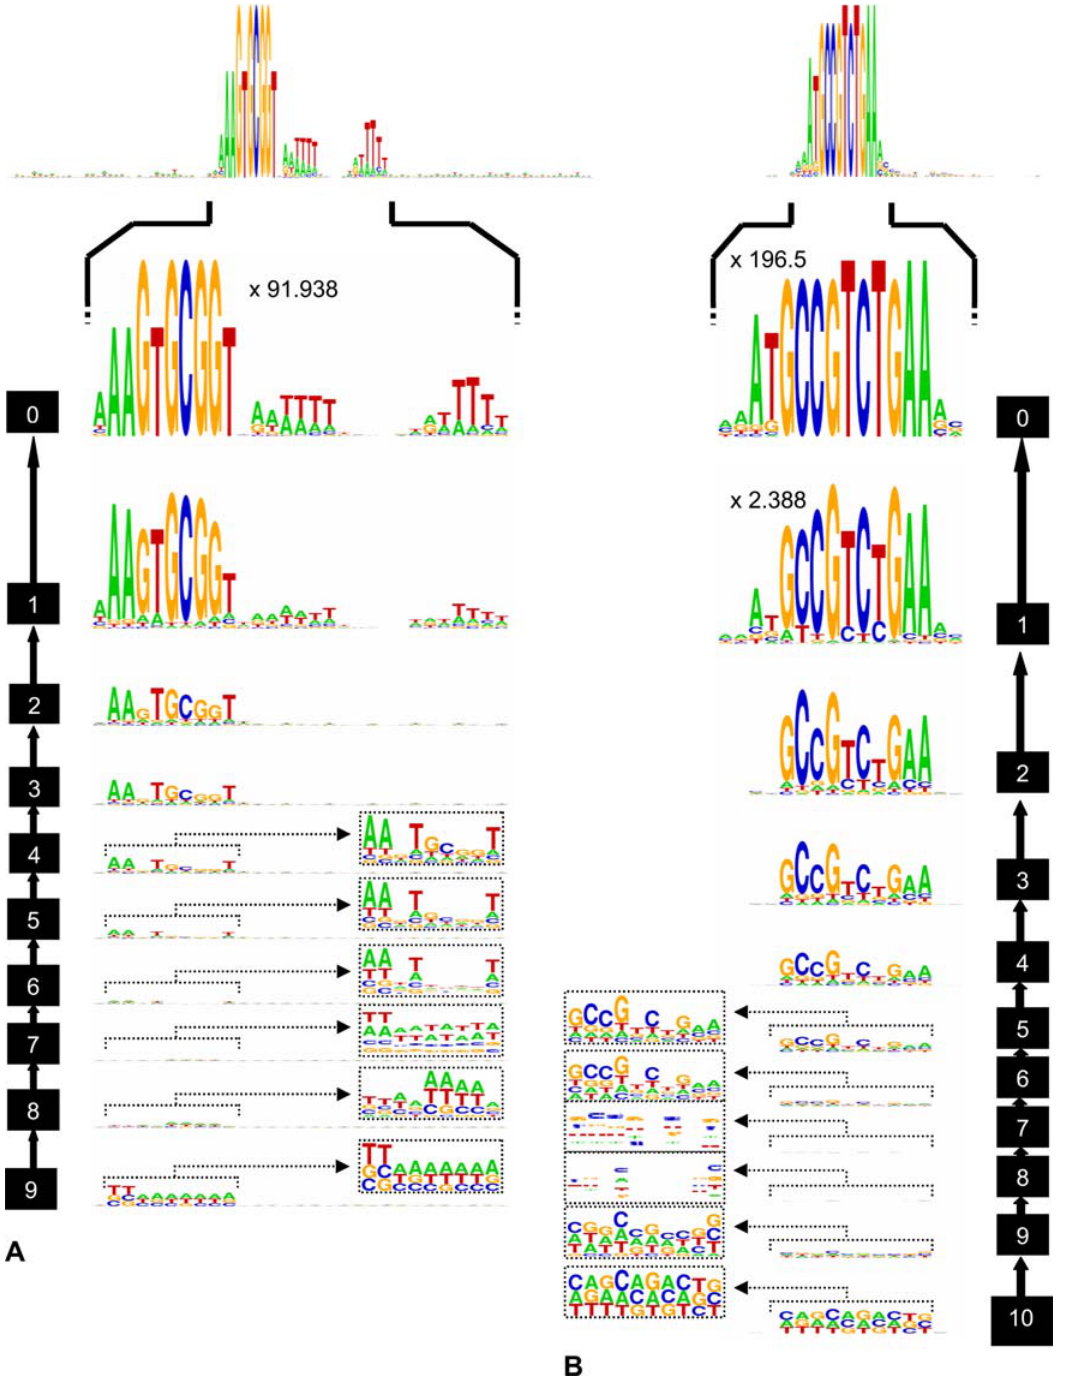
Figure 3. DNA sequence logos showing the accumulation of H.influenzaeand N.gonorrhoeaeDUES nucleotides. The heights of the characters reflect the conservation of the nucleotides ([equation 3 in 66]) as well as the genomic representation of sequences at the mismatch load (equation 2). The number to the side of each logo is the mismatch load analyzed. The height of the logo should be multiplied by the number at the top, if applicable.